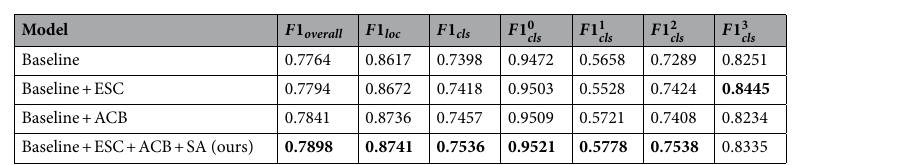
Table 5. Results of ablation experiments for building damage assessment. Significant values are in bold.